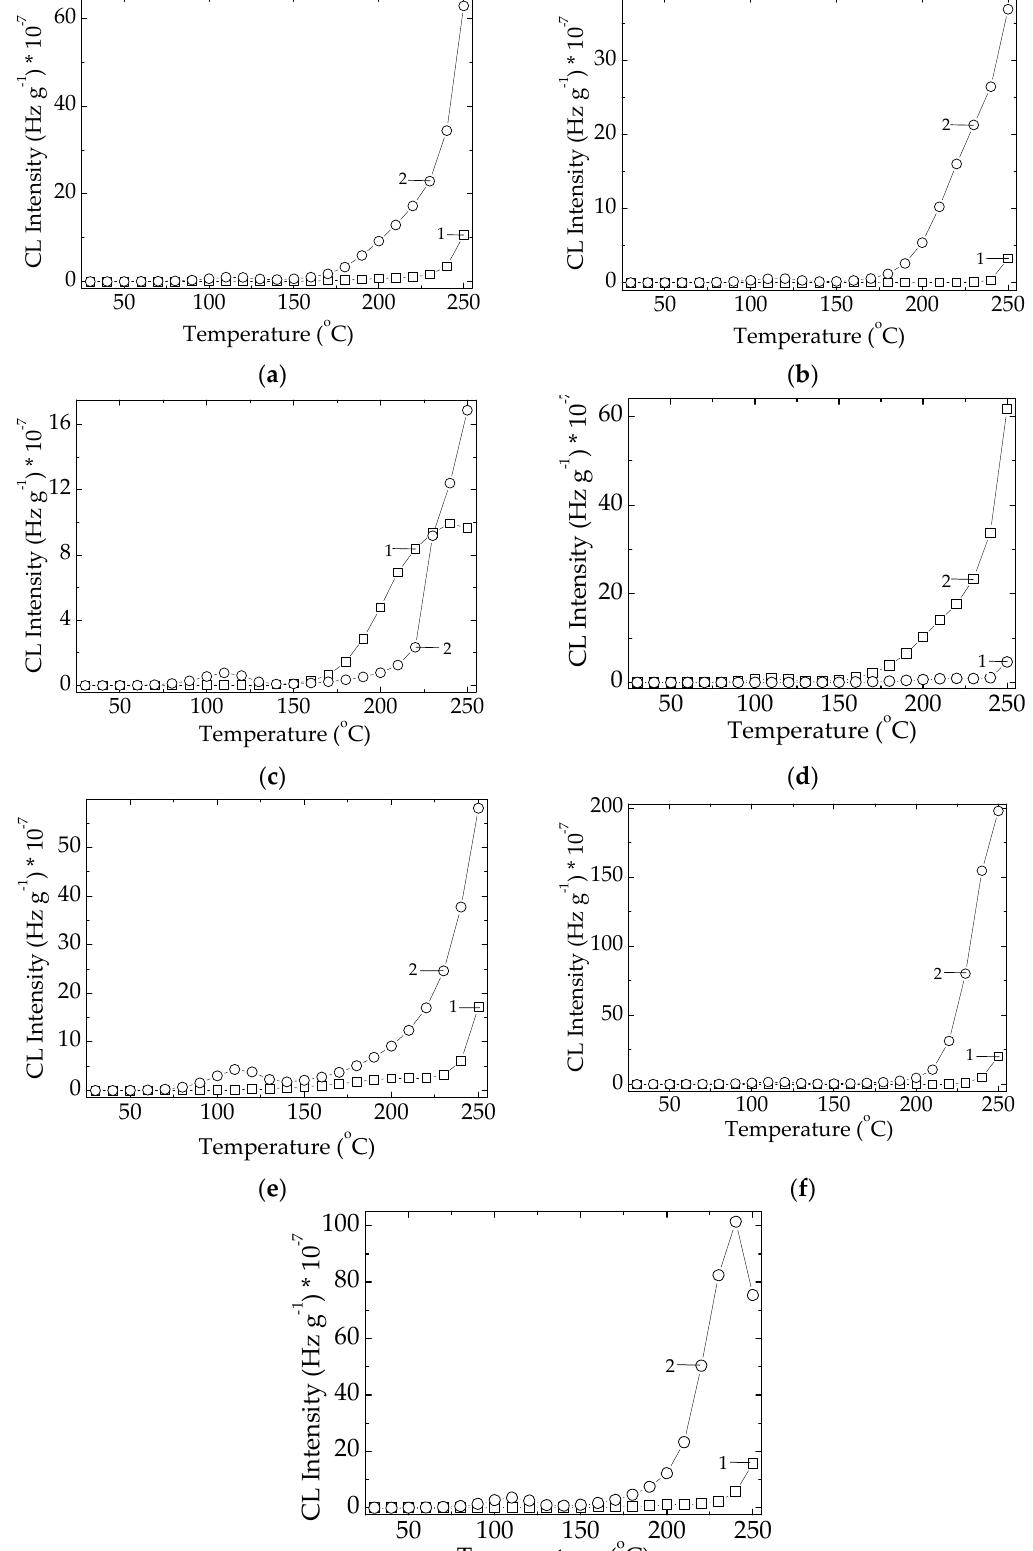
Figure 9. The nonisothermal CL spectra of studied POSS powders exposed to two irradiated doses. Heating rate; 10 °C min − 1 . ( a ) P 1; ( b ) P 2; ( c ) P 3; ( d ) P 4; ( e ) P 5; ( f ) P 6; ( g ) P 7. (1) D 0 kGy; (2) 50 kGy.